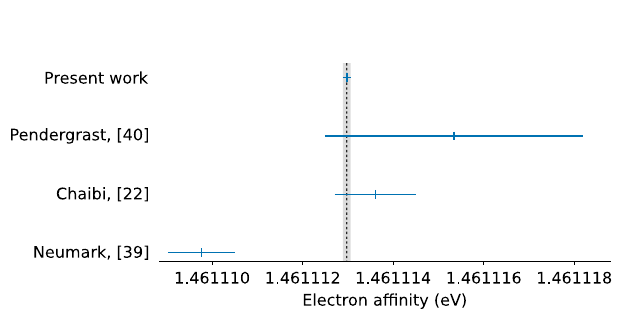
Fig. 5| Comparisonwithpreviousexperimentalresultsoftheelectronaf fi nity, in eV, of 16 O. Our measured electron af fi nity is compared with a selection of the previous experimental results. The uncertainties are the ones given in each corre- sponding